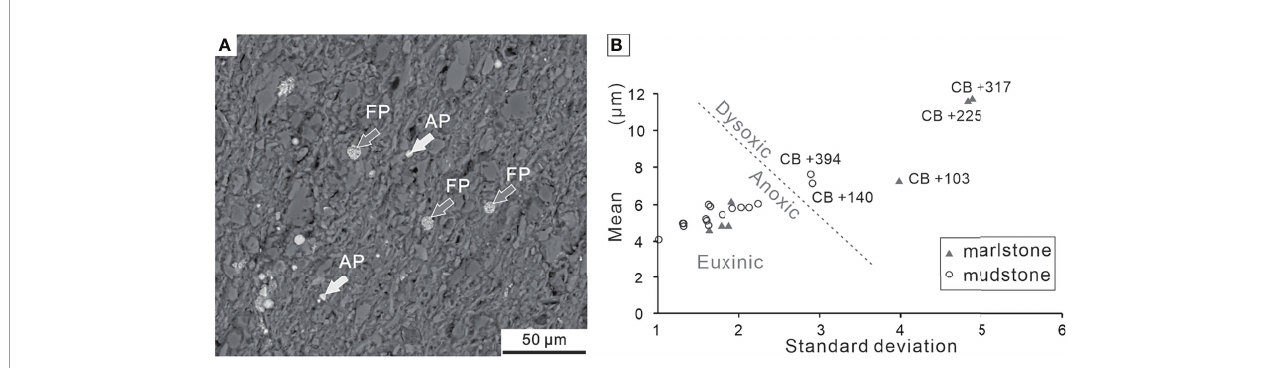
FIGURE 12 | (A) Overview of BSE images of framboidal pyrites and authigenic pyrites from Bed 19 of the Chibi section. (B) Cross-plot of mean diameter vs. standard deviation of pyrite framboids from the Chibi section. The boundary (dotted line) separating dysoxic and anoxic/euxinic fi elds is from Bond and Wignall (2010). FP, framboidal pyrites; AP, authigenic pyrites.